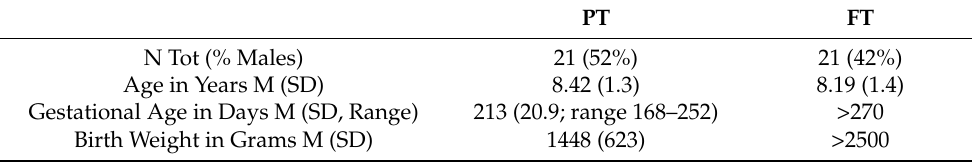
Table 1. Demographic characteristics of the participants. PT = Preterm; FT =